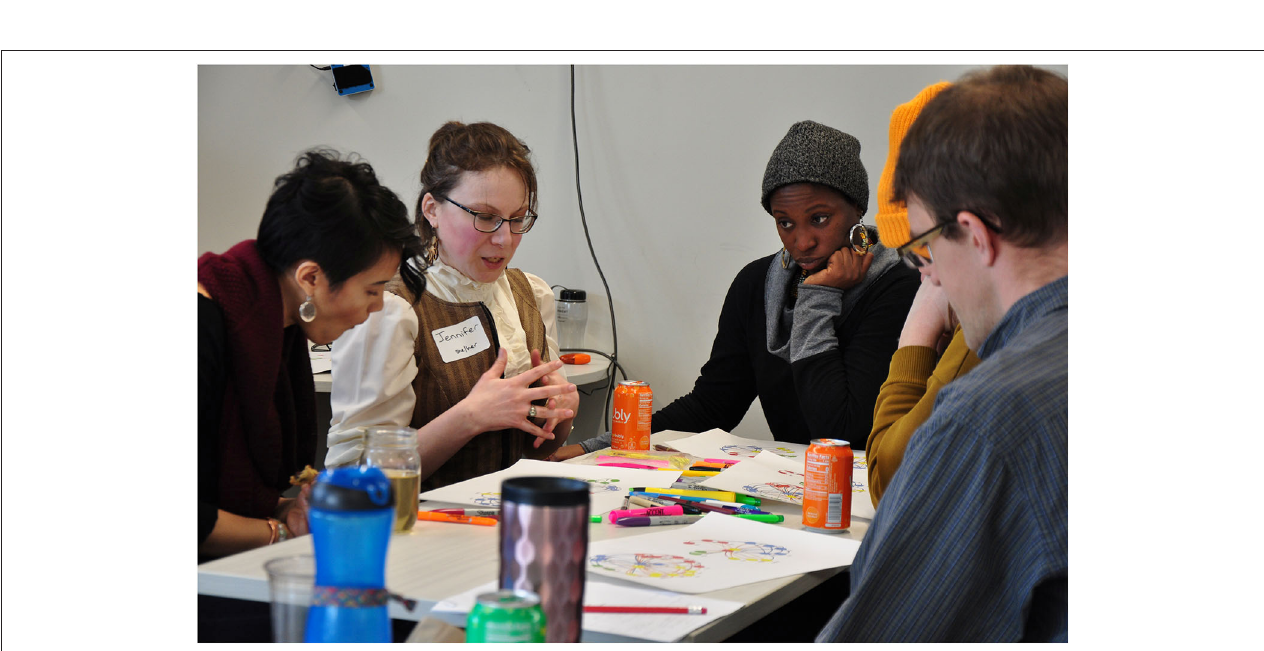
FIGURE 8 | All-Hands meeting as an embodied space. Photo credit: Stacy Nordstrom. Coming together as a full group at the yearly All-Hands meeting is a ceremony/ritual that helps us mark the start of another year, and in 2020, we used results from the evaluation to add more aspects of embodied learning experiences. Here, partners from the Coalition, Knoll Farm, and Sandhill Farm, plus researchers Jennifer (second from left) and Chip (far right), are working through the meaning-making process for the relationship network analysis. Creating physical things to interact with (like the printout and pens) as well as using small groups and circle process are one way that sharing ceremonies/rituals in embodied learning experiences are helping us understand how others share stories and create meaning from symbols.